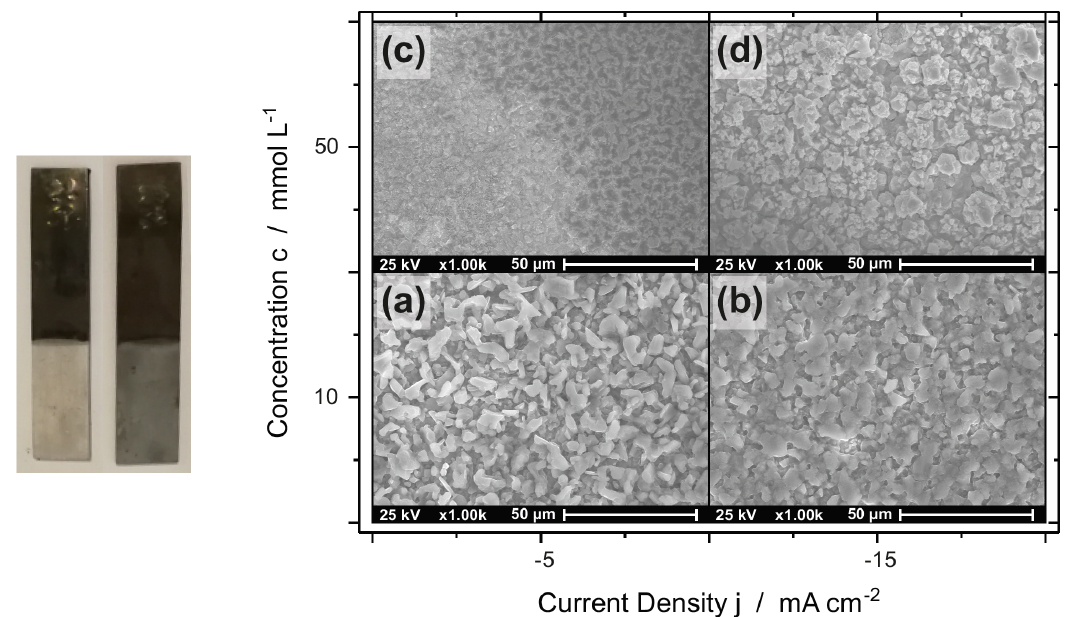
Figure 3. Photographs of AlZn coatings on steel with increasing Zn content (left to right: 3.0 wt% and 23.4 wt%) and SEM images of AlZn alloys on steel substrate, deposited at −5 mA cm −2 ( a , c ) and −15 mA cm −2 ( b , d ) from [EMIm]Al 2 Cl 7 –10Zn (a,b) and [EMIm]Al 2 Cl 7 –50Zn ( c , d ).